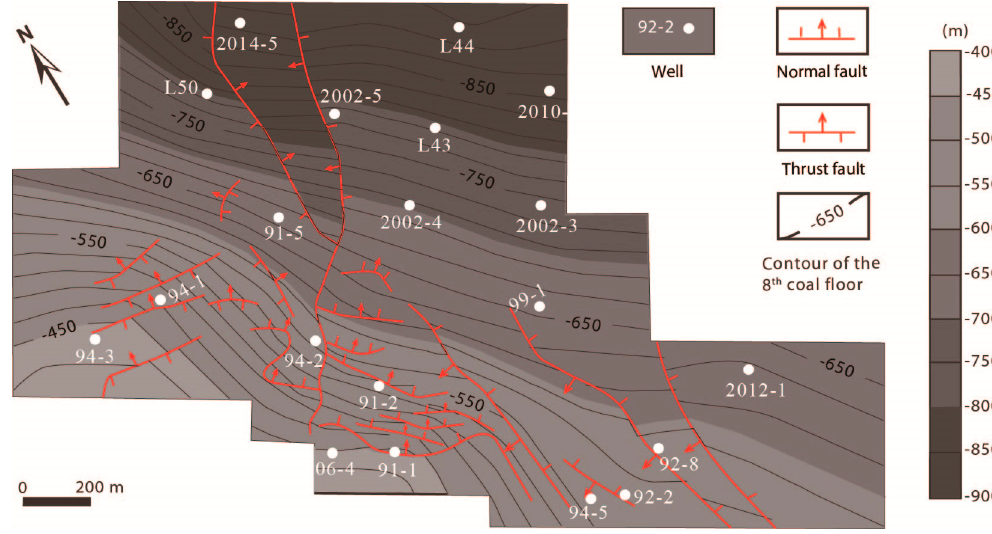
Figure 6. An overview map of No. 8 coal’s elevation. Table 3. Well-logging measured TDC thickness of No. 8 coal.